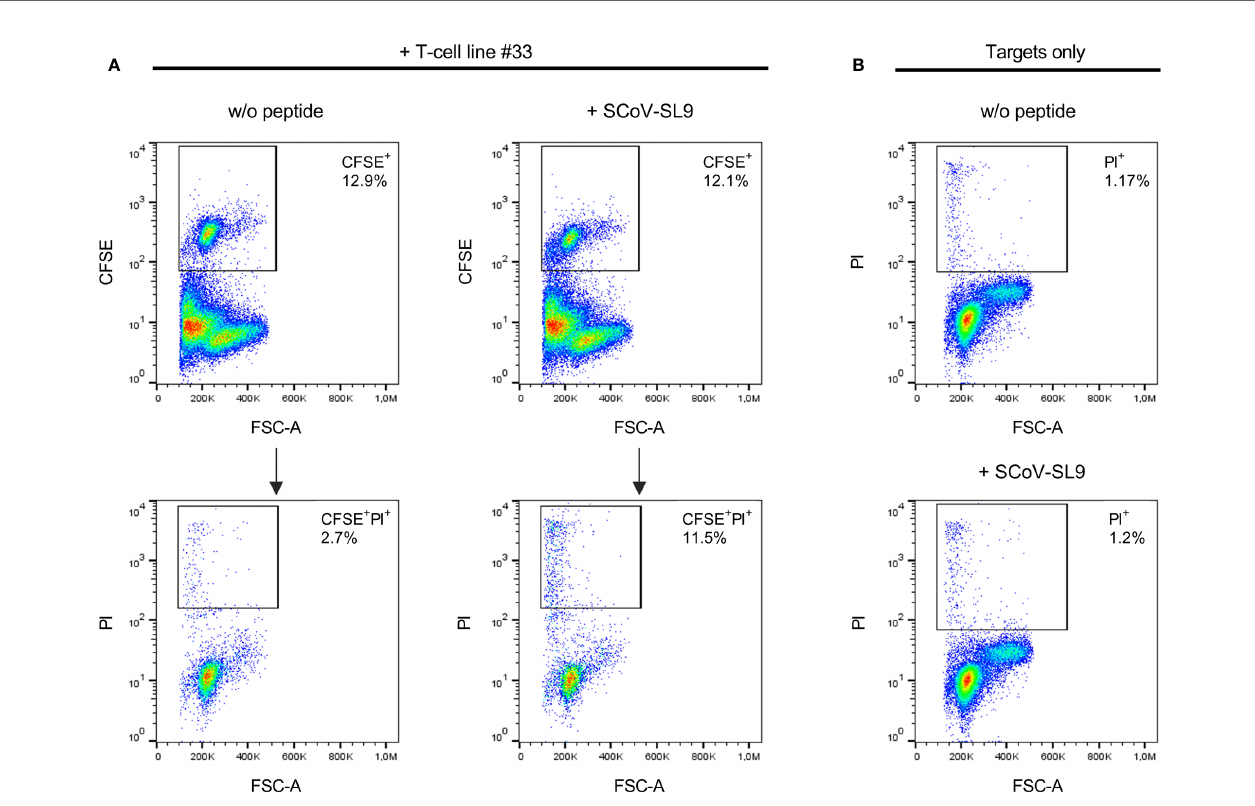
FIGURE 5 | SCoV-SL9-speci fi c T-cell lines exhibit peptide-speci fi c cytotoxicity. (A) Lysis of SCoV-SL9-sensitized target cells by SCoV-SL9-speci fi c T-cells. Autologous PBMCs from donor 33 were used as target cells and loaded with 20µg/ml SCoV-SL9 peptide (SPRWYFYYL) followed by carboxy fl uoresceinsuccinimidylester. (CFSE) cell tracker staining. 3x10 4 target cells were co-incubated with 3x10 5 cells of a SCoV-SL9-speci fi c T-cell line obtained from donor #33. Target cells without peptide (w/o peptide) served as control. After 18h, cells were harvested and stained with propidium iodide (PI) to assess viability and cell death (PI + cells) was analyzed in the CFSE + population. Shown are the percentages of CFSE + target cells within the cell suspension (upper panel) as well as the percentages of PI + cells in the CFSE + population (lower panel: PI + cells: without peptide: 2.7%, with SCoV-SL9-peptide: 11.5%). (B) As control for spontaneous cell death within the targets cells, 3x10 5 target cells each were cultured either with SCoV-SL9 peptide or without peptide (w/o peptide) for 18 hours without addition of SCoV-SL9-speci fi c T-cells. Cell death was assessed as under (A) . PI + cells: w/o peptide: 1.17%, with SCoV-SL9 peptide: